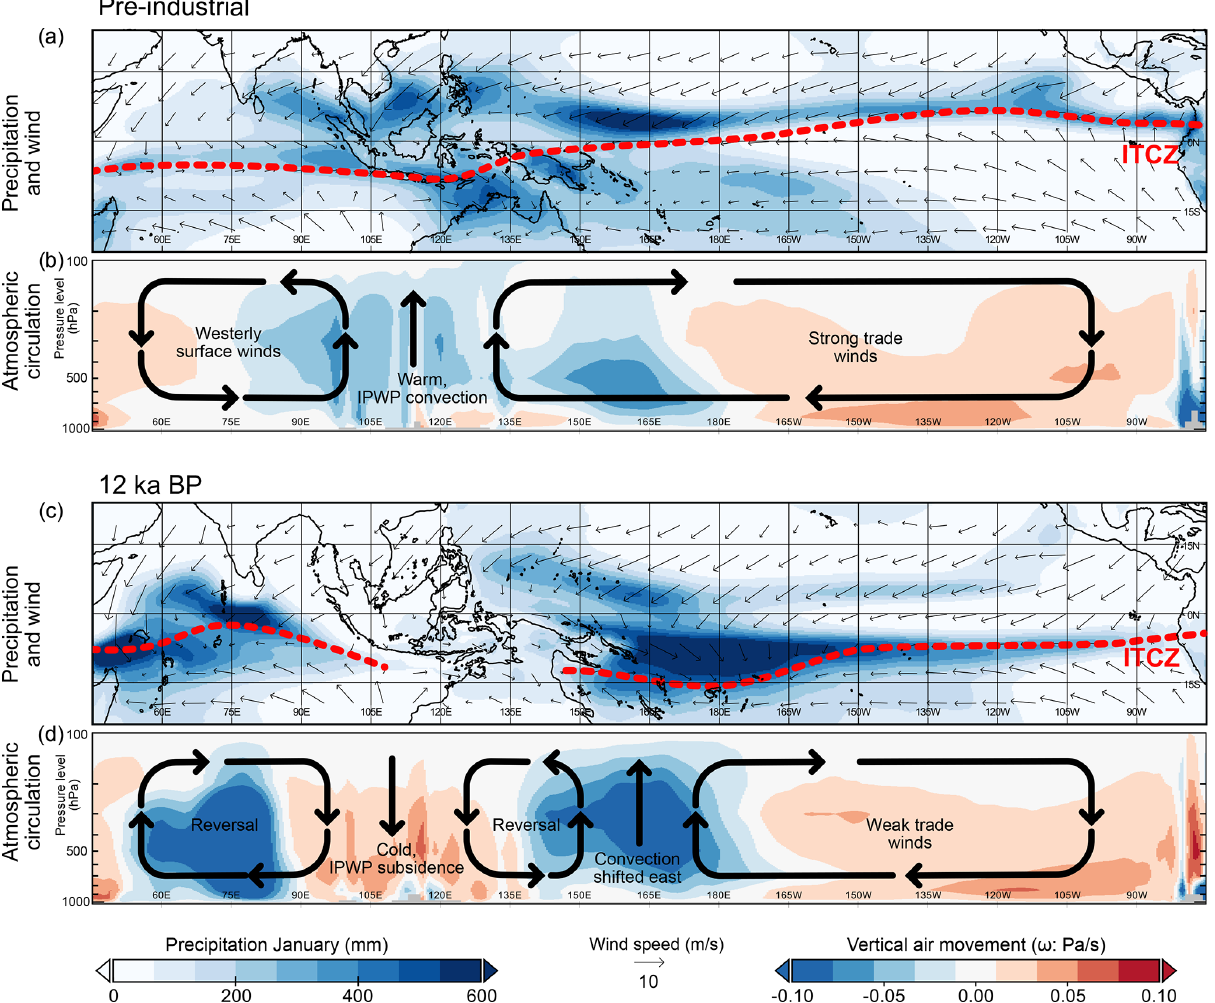
Figure 5. Simplified mechanistic explanation for January precipitation patterns during the preindustrial (a, b) and 12kaBP (c, d) in terms of horizontal and vertical wind patterns. (a) and (c) show mean total precipitation (mm per month) and surface wind vectors (ms − 1 ) for January; (b, d) Omega parameter ( ω : Pas − 1 ) representing vertical air movement ( ω < 0, rising in blue; ω > 0 sinking in red) along the Equator over the Indo-Pacific region. The approximate January location of the ITCZ and atmospheric Walker Circulation patterns are indicated as red lines (a, c) and black arrows (b, d) , respectively. Note that the atmospheric circulation cells are inverted over the IPWP region at 12kaBP where subsiding air masses, a breakdown of deep convection and divergent winds from land to sea cause seasonal aridity over tropical land areas. For details on the weakening and/or reversal of the zonal winds, see Fig.